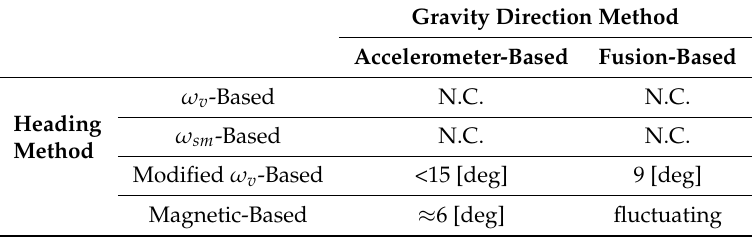
Figure 3. Comparing estimated heading profiles as obtained by the magnetic-based and the three gyroscope-based methods. Upper and lower panes show the results when each of the gravity direction estimation methods is applied. Table 2. Comparison results summary for all combinations of the various methods, showing the error in heading angle during the last segment of the 85-second scenario (N.C. values indicate errors that are quickly drifting and